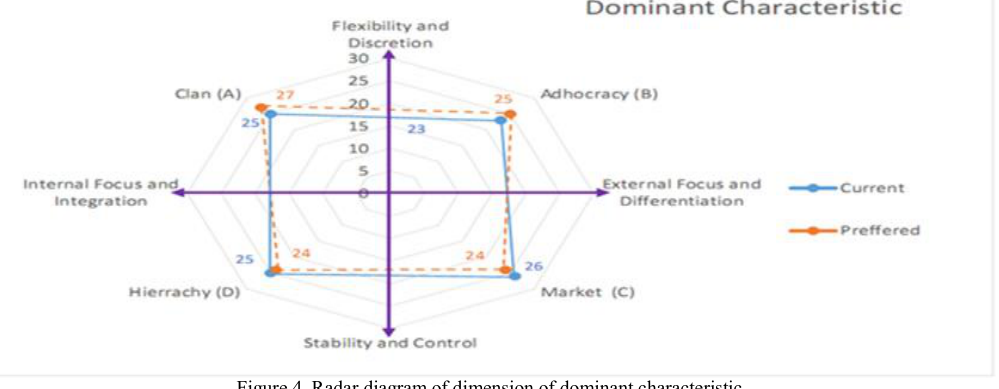
Figure 4. Radar diagram of dimension of dominant characteristic